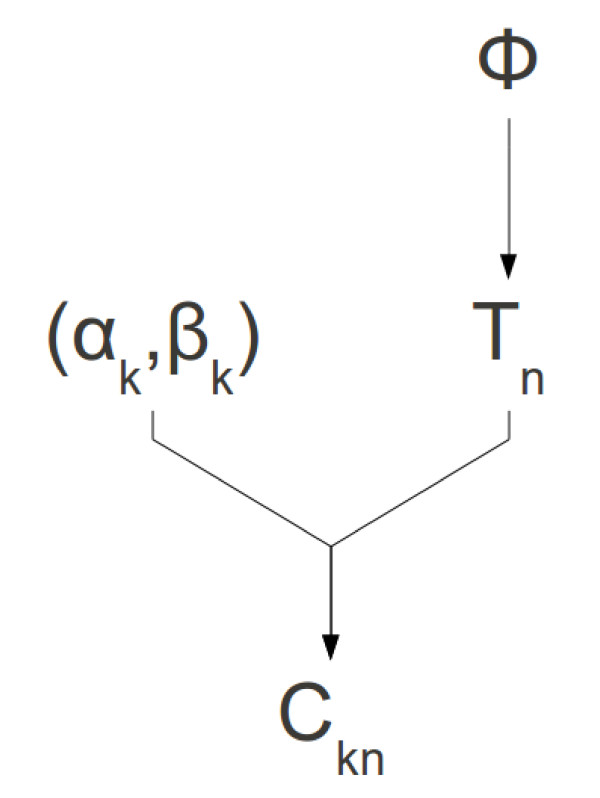
Conditional dependencies of the model. The dependencies of parameters in the model. ϕis the proportion of the population that is positive for the feature of interest, Tnis the true classification of individual n, αkand βkare the probabilities of a true positive and a false positive (respectively) for classifier k, and Cknis the classification of individual n according to classifier k.